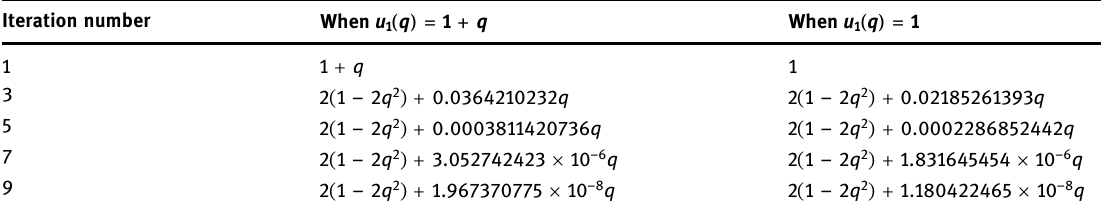
Table 4: Approximated values of ( ) u q